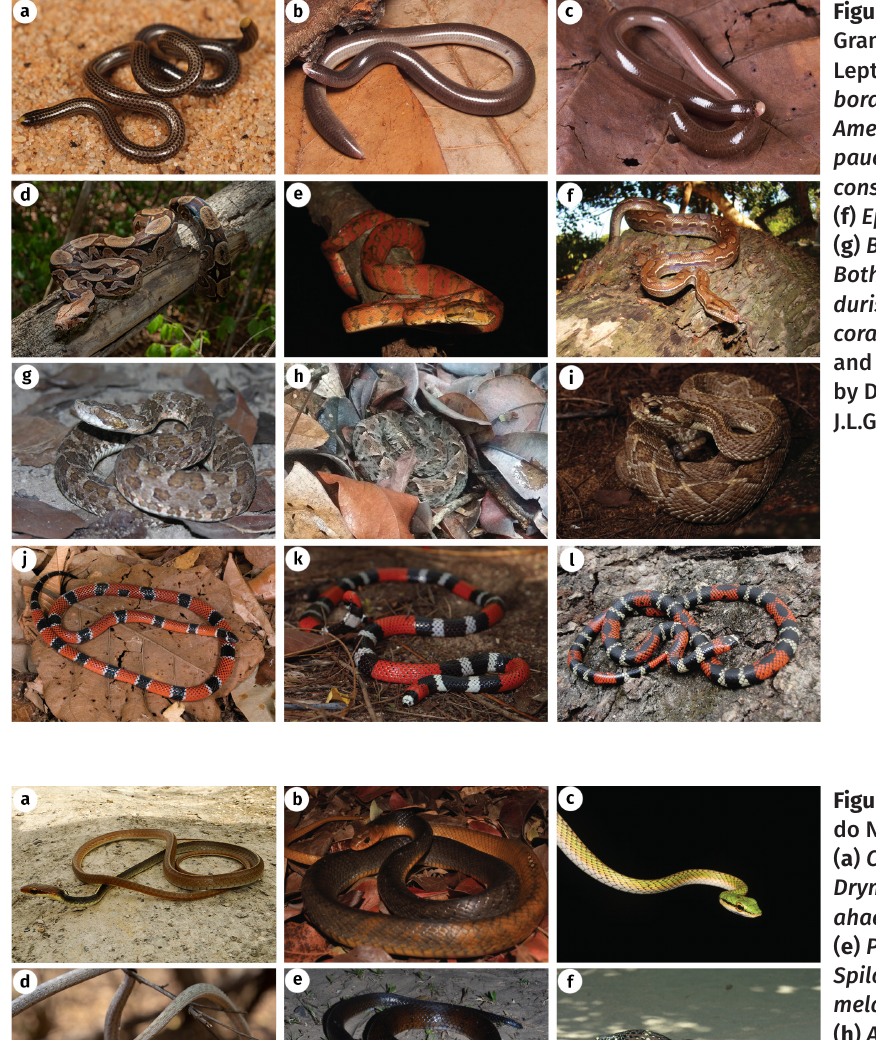
Figure 3. Snakes from Rio Grande do Norte state, Brazil. Colubridae: ( a ) Chironius flavolineatus , ( b ) Drymarchon corais , ( c ) Leptophis ahaetulla , ( d ) Oxybelis aeneus , ( e ) Palusophis bifossatus , ( f ) Spilotes pullatus , ( g ) Tantilla melanocephala . Dipsadidae: ( h ) Apostolepis cearensis , ( i ) A . longicaudata , ( j ) Boiruna sertaneja , ( k ) Dipsas mikanii , and ( l ) Erythrolamprus almadensis . Photo e by D.J. Santana.